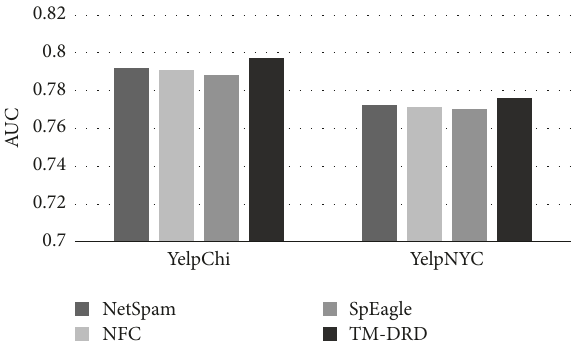
Figure 7: The AP and AUC of TM-DRD in different deceptive re- view ratios.